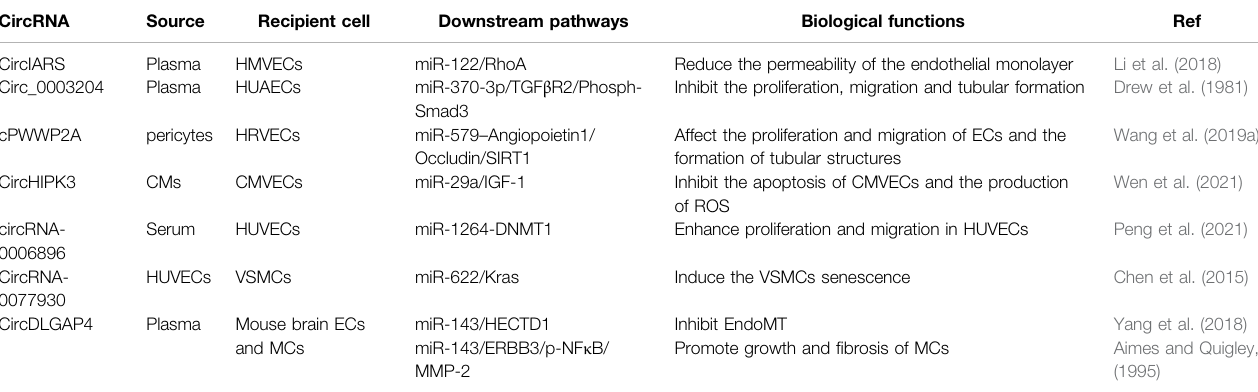
TABLE 2 | EV-circRNAs and their partners related to atherosclerosis.